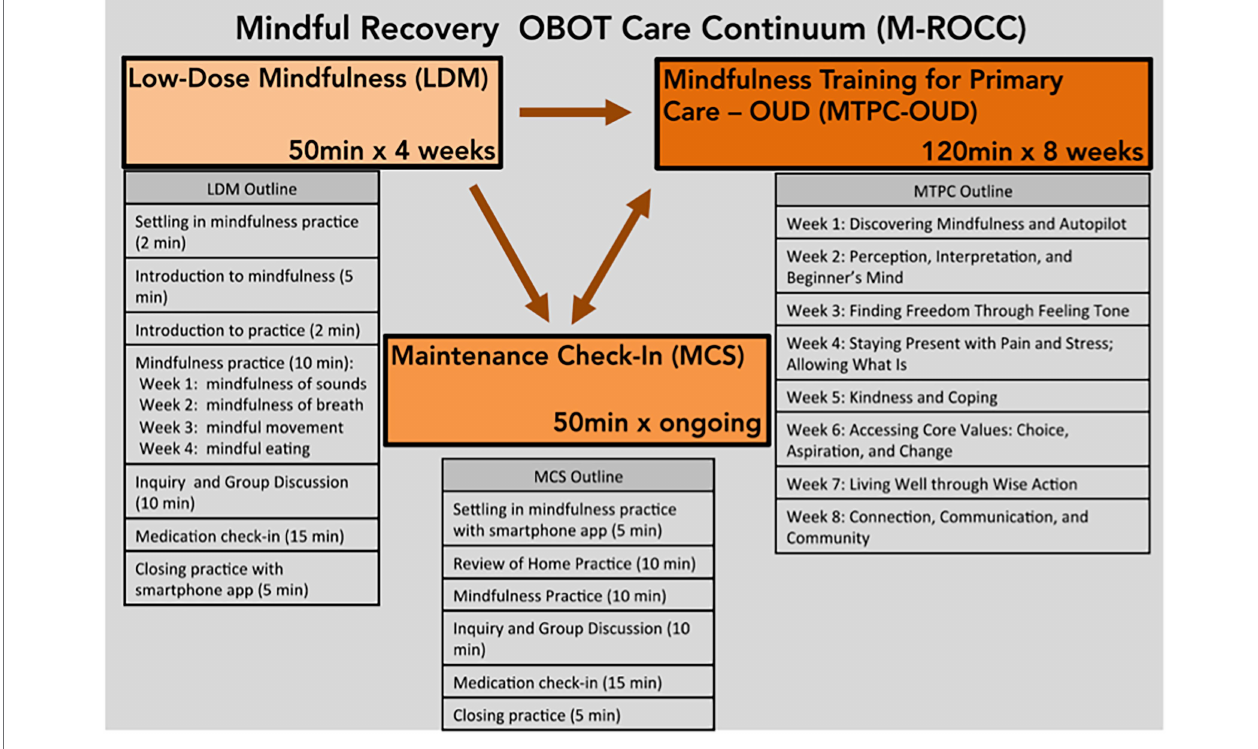
FIGURE 1 | M-ROCC flow